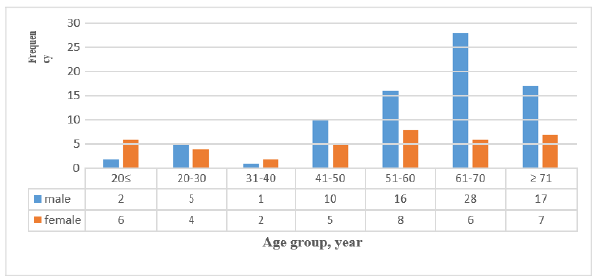
Fig. 1. Sex distribution according to age group among infected